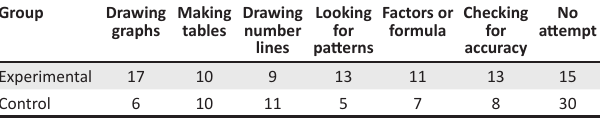
TABLE 2: Frequencies of learners using quadratic inequality problem-solving strategies. Group Drawing Making Drawing graphs tables